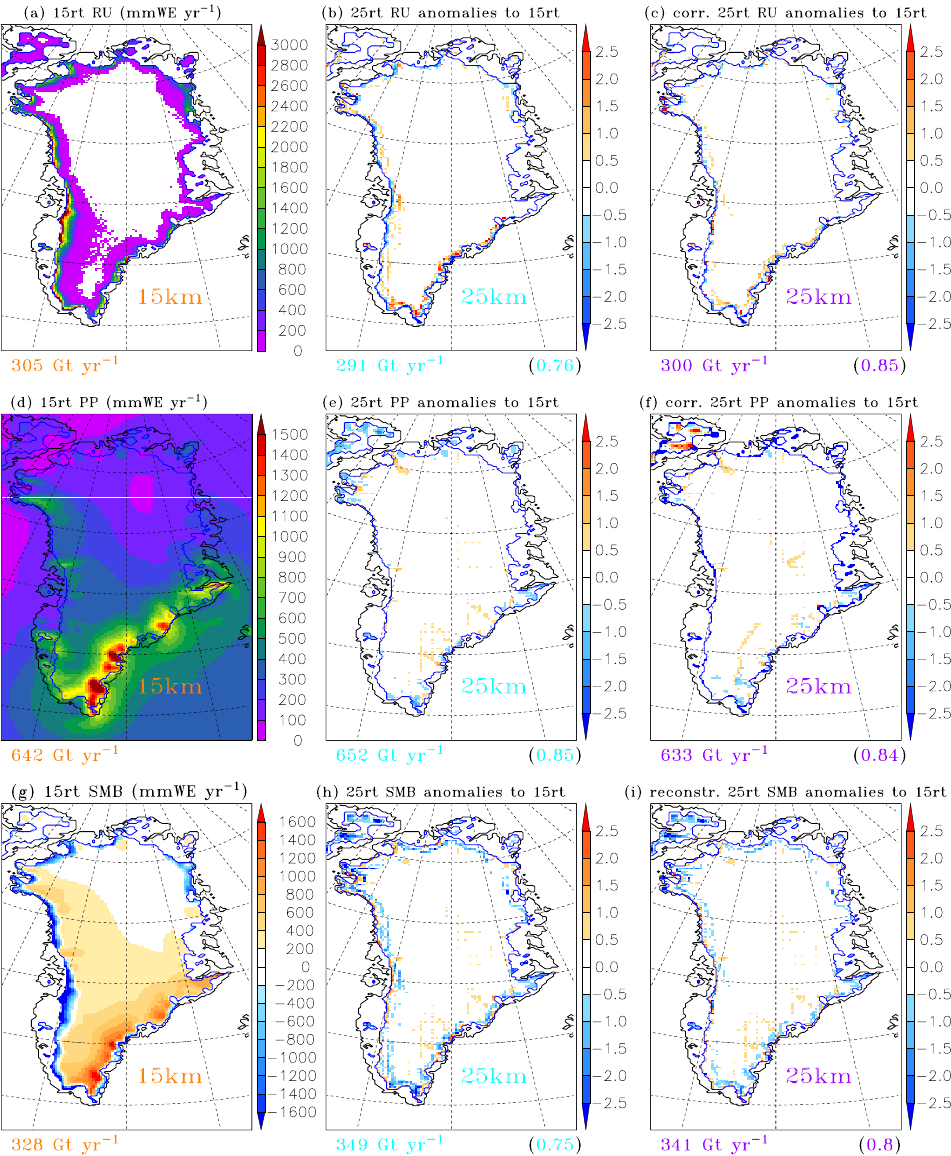
Fig. 7. (a) Annual run-off of meltwater (mmWEyr − 1 ) simulated by the MAR model at 15km resolution (15rt), over the 1990–2010 period. On the bottom left side of the view is the total run-off of meltwater (Gtyr − 1 ) from the GrIS, on the 15km ice sheet mask. (b) Annual run-off anomalies (in standard deviation) of the 25km resolution outputs (25rt) interpolated onto the 15km ice sheet mask, compared to (a) . On the bottom right side, in brackets, is the skill score of the interpolated field compared to the 15rt outputs. (c) The same as (b) , but for the 25rt outputs interpolated onto the 15km GrIS mask and corrected with daily gradients. (d–f) The same as (a–c) , but for the annual precipitation (mmWEyr − 1 ) simulated by the MAR model. (g–i) The same as (a–c) , but for the annual SMB (mmWEyr − 1 ) simulated by the MAR model, and the reconstructed SMB from the corrected 25rt